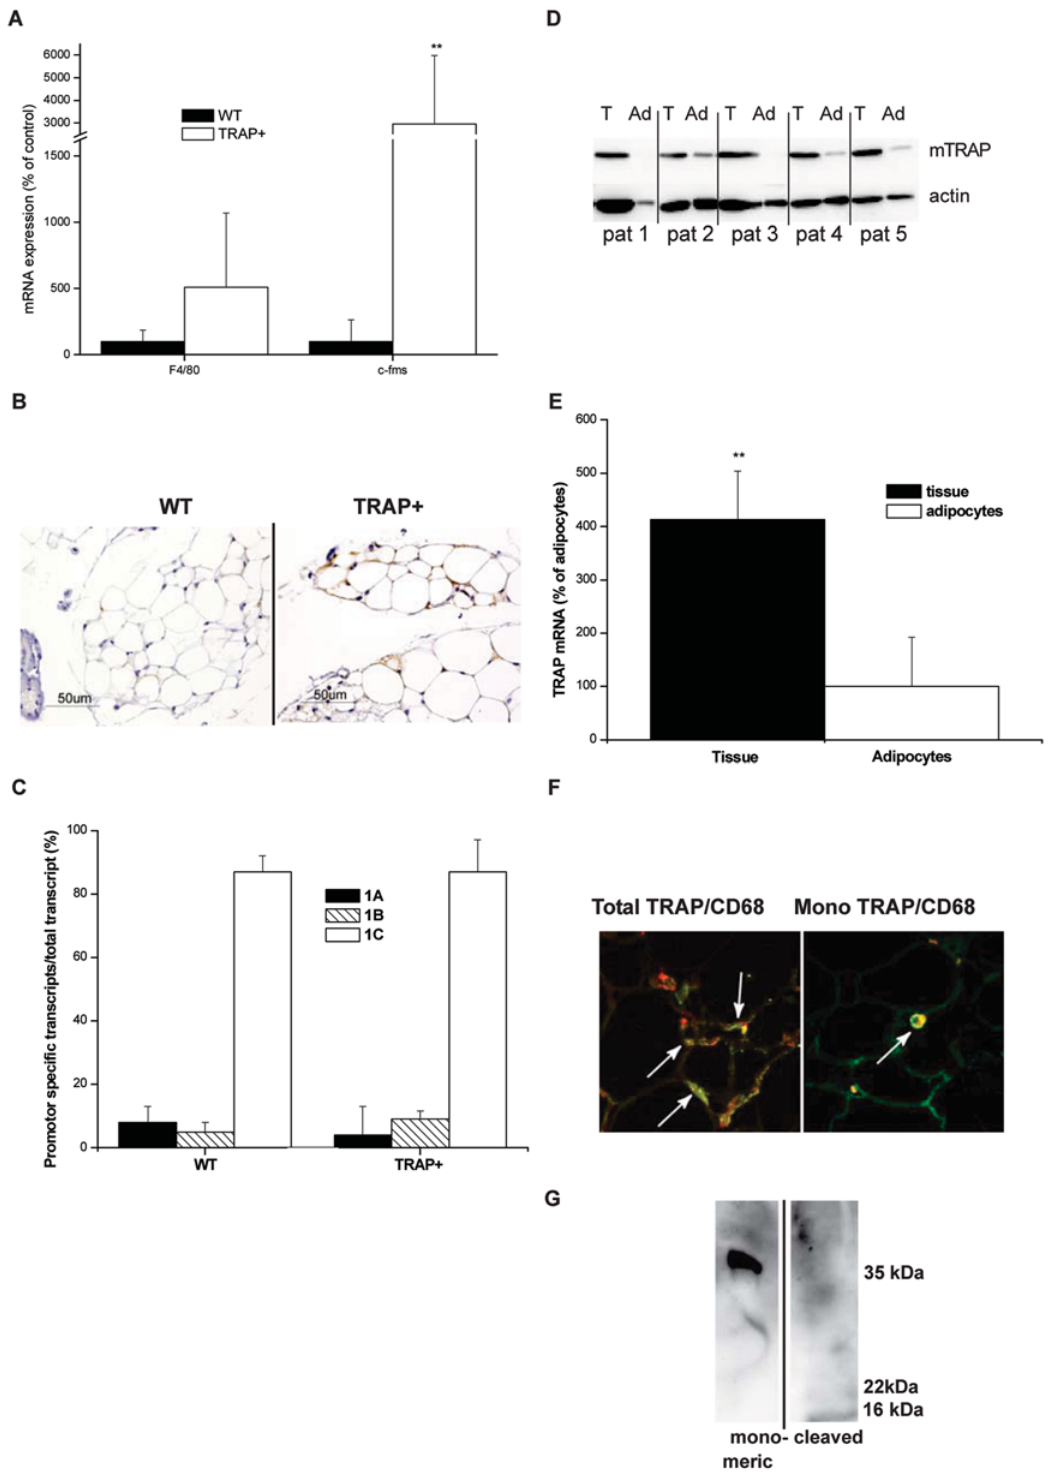
Figure 5. Macrophages are the primary source of monomeric TRAP in mouse and human adipose tissue. (A) mRNA expression of the monocyte/macrophage marker F4/80 and c-fms in adipose tissue of TRAP + vs. WT mice. (B) Immunohistochemistry of mouse macrophage marker F4/ 80 in adipose tissue from TRAP + compared to WT mice (C) mRNA for the myeloid lineage specific TRAP transcript 1C in adipose tissue of WT and TRAP + mice. (D) Expression of monomeric TRAP in adipose tissue (T) and isolated adipocytes (Ad) from five subjects (Pat 1–5). (E) TRAP mRNA expression in human adipose tissue and in isolated adipocytes. (F) Co-localization between monomeric or total TRAP and the macrophage marker CD68 in subcutaneous human adipose tissue from a representative subject. (G) Monomeric TRAP is secreted from the mouse macrophage cell line RAW 264.7 (lane 1), whereas proteolytically processed TRAP is not detectable (lane 2).